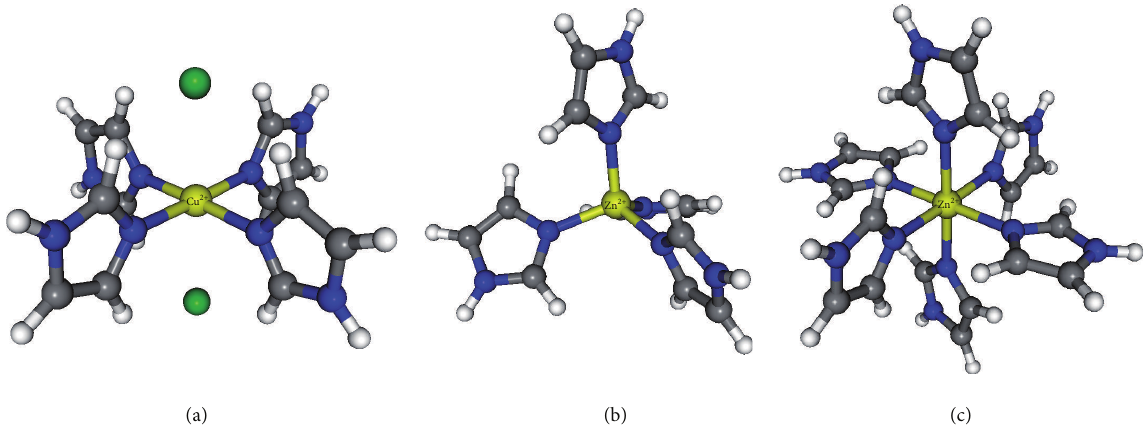
Scheme 6: Coordination geometries for imidazole-Cu(II) or -Zn(II) complexes [38]. (a) Square planar [Cu(Im) 4 ] 2+ . (b) Tetrahedral [Zn(Im) 4 ] 2+ . (c) Octahedral [Zn(Im) 6 ] 2+